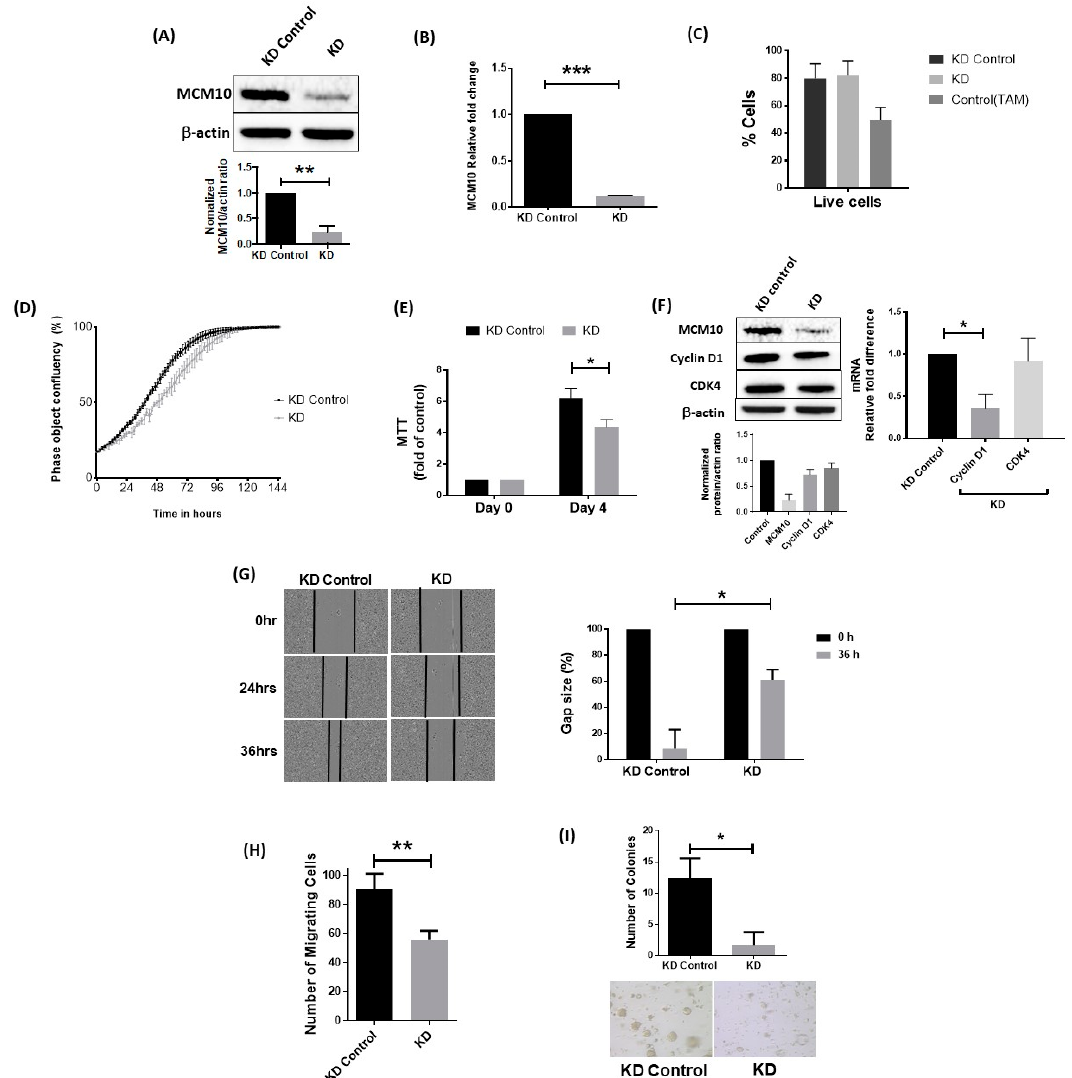
Figure 5. Cancer hallmarks of stable MCM10 knockdown (KD) in MCF 7 cells. ( A , B ) relative expression of MCM10 in stable MCM10-KD MCF 7 cell lines assessed by qPCR and Western blots ( n = 3, *** p < 0.001); ( C ) apoptosis analysis by Annexin V/Propidium Iodide flow cytometry showed